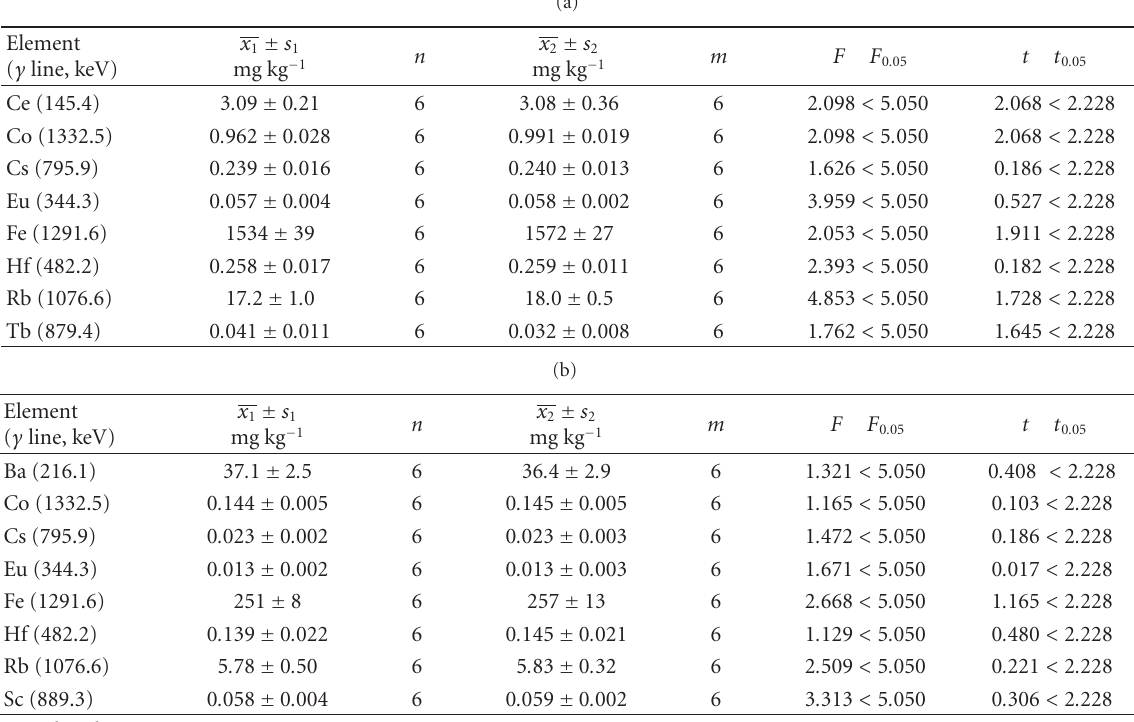
Table 1: Homogeneity testing of the candidate reference materials: INCT-OBTL-5 (a) and INCT-PVTL-6 (b) for 100 mg sample by NAA using Fisher’s test and Student’s t